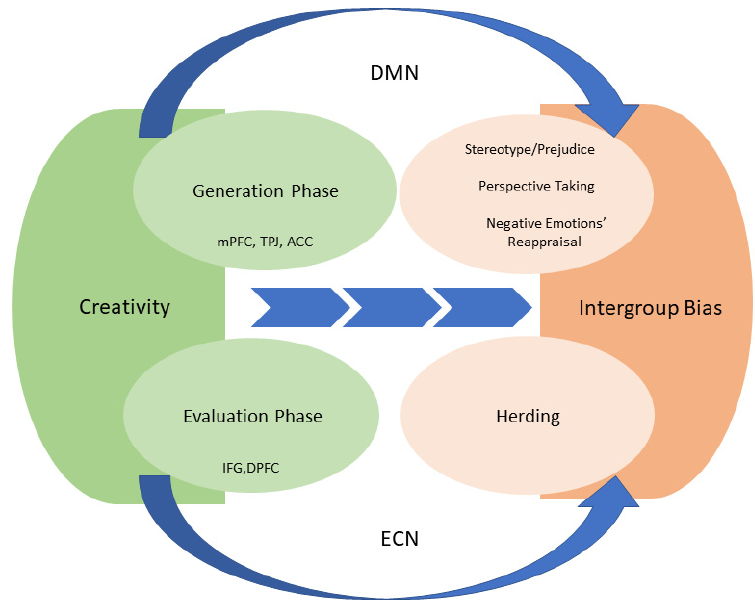
Figure 2. The underlying mechanism of creativity as an intervention for peace. According to our model, increased creative thinking involves the generation phase comprising the mPFC and TPJ. This phase is linked to enhanced reappraisal and perspective taking and to reduced stereotypes and prejudice. Increased creative thinking also involves the evaluation phase comprising the IFG. This phase is linked to reduced herding.